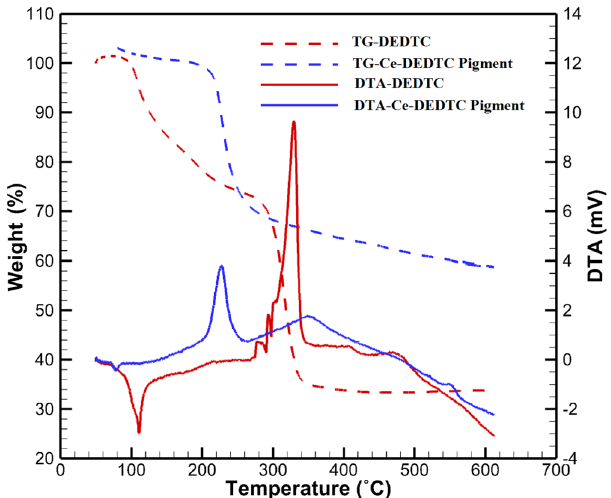
Figure 3. The TG-DSC analysis of the parent DEDTC and Ce-DEDTC